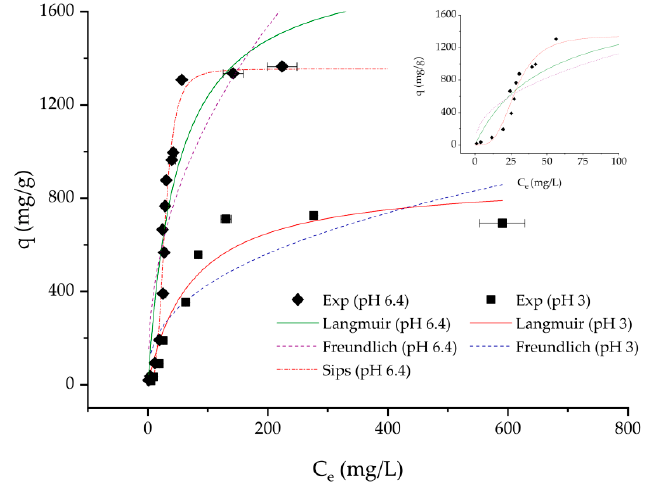
Figure 7. Effect of pH on adsorption isotherm of methylene blue in DCMC 3. Figure 7. E ff ect of pH on adsorption isotherm of methylene blue in DCMC